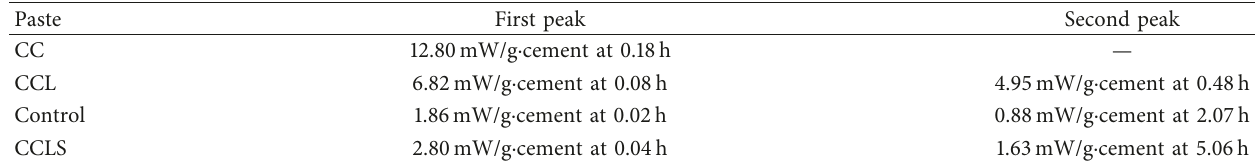
Figure 6: Heat flow over time during cement hydration. Table 1: Maximum heat evolution rate and peak position.